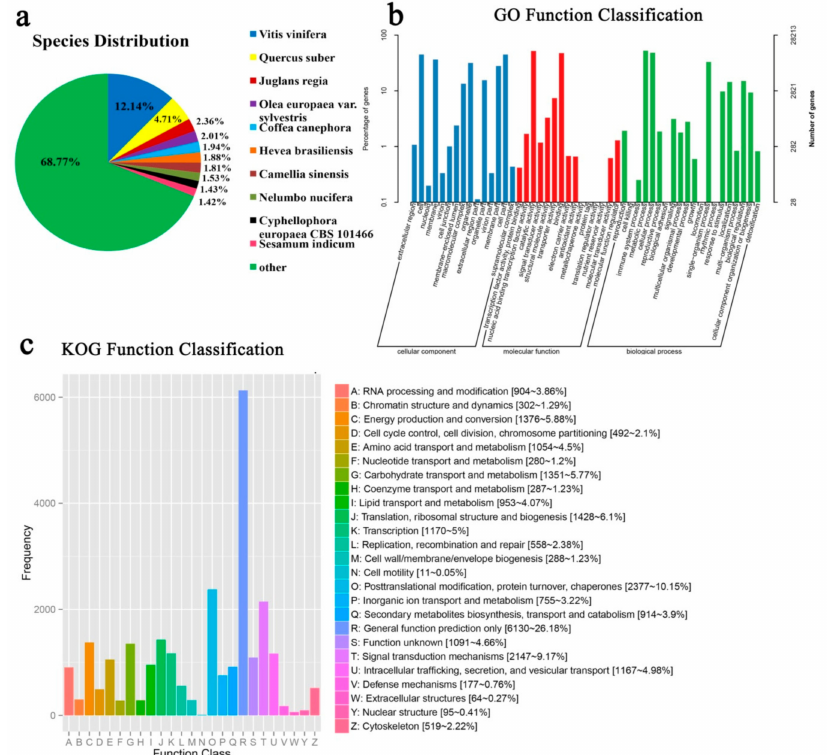
Figure 2. Functional annotations of the assembled transcriptome. ( a ) NR annotated species distribution map similar to the Camellia oleifera ‘Huaxin’ transcriptome; ( b ) GO classification of the annotated unigenes; ( c ) KOG function classification of the consensus